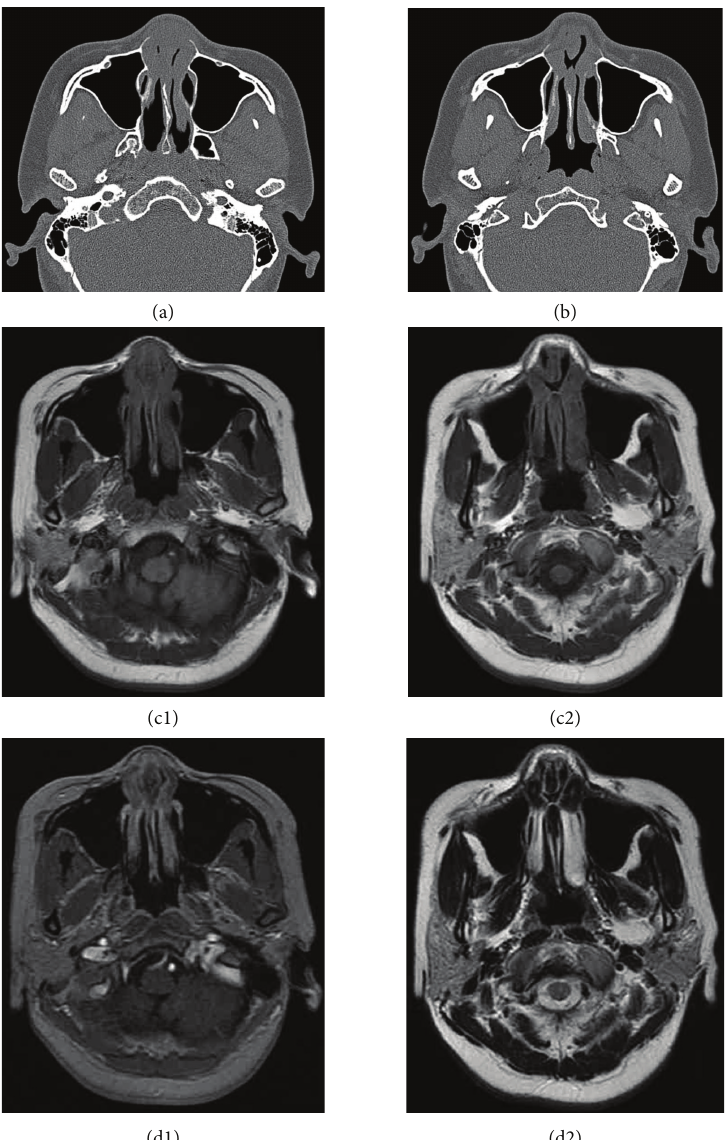
Figure 3: (a) The lesion appears to have homogeneous isodensity to gray matter on the nonenhanced CT. (b) The anterior nasal septum perforation was identified with its size approximately 1.3 ∗ 1 cm. (c1, c2) On the T1-weighted image, the anterior part of the septum and adjacent lateral nasal wall appear to be isointense to gray matter. (d1, d2) On the T2-weighted image, the anterior septum and bilateral headend of inferior turbinate are